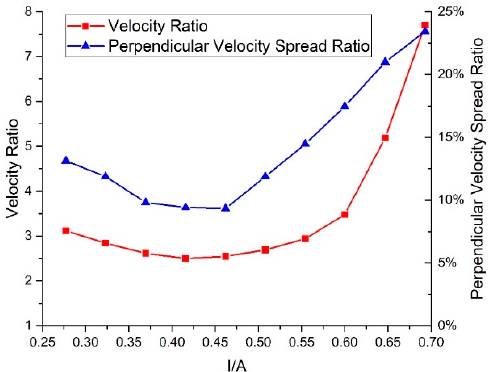
Figure 7. Sensitivity analysis of beam velocity ratio and perpendicular velocity spread ratio for modulating anode voltage.